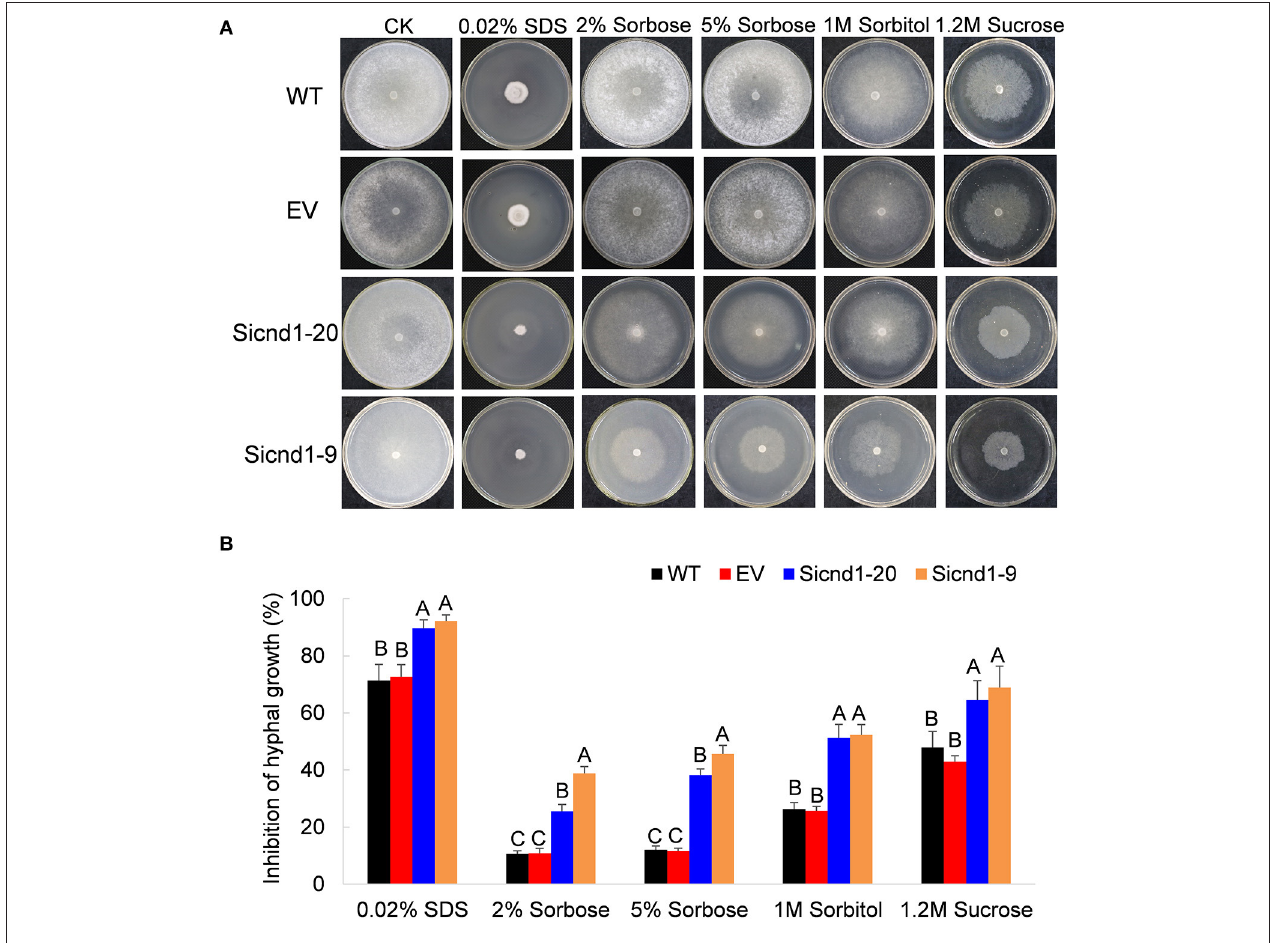
FIGURE 6 | The growth of Sscnd1 gene-silenced strains in the presence of various stressors. Phenotypes (A) and growth inhibition (B) of the wild-type strain (WT), empty vector strain (EV), Sicnd1-9 and Sicnd1-20 grown on PDA supplemented with 0.02% SDS, 2% sorbose, 5% sorbose, 1M sorbitol, and 1.2M sucrose, respectively. Photographs were taken at 3 dpi (days post inoculation). One representative biological replicate is shown. Error bars indicate the standard deviation for three replicates. Differences in every stressor group were assessed using Tukey’s HSD test. Different letters indicate statistical significance at the 0.05 level ( P <